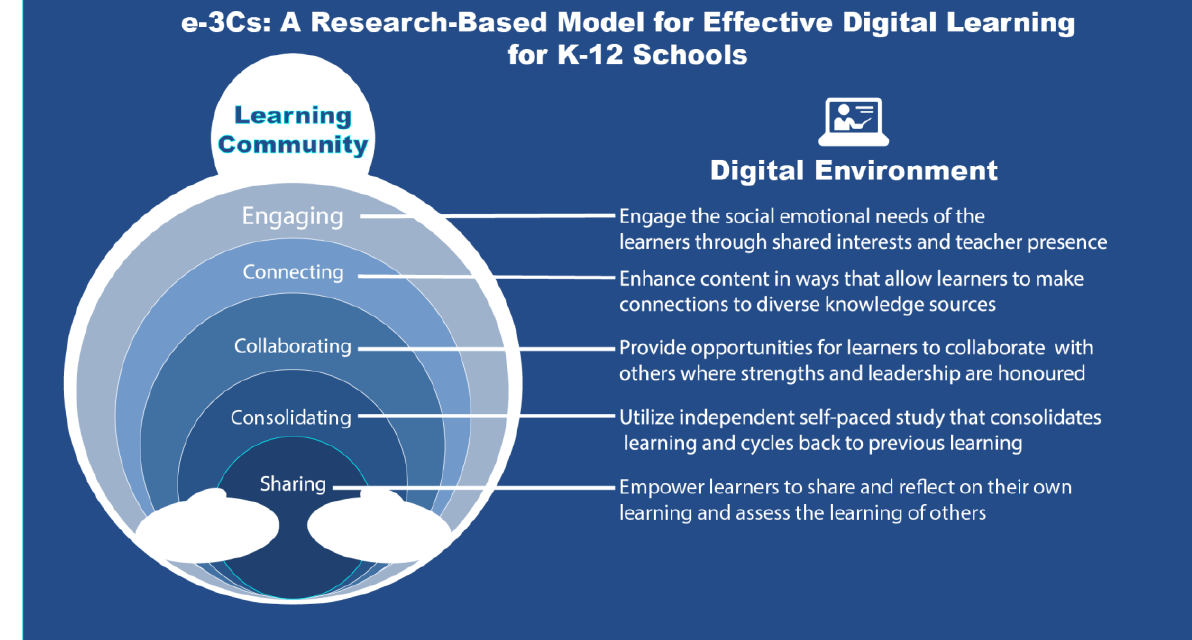
e-3Cs: A Research-Based Model for Effective Digital Learning for K  12